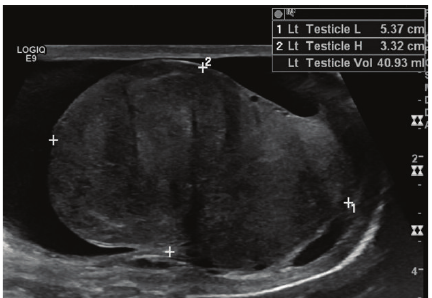
Figure1:Testicularultrasound.Longitudinalexaminationoftheleft testisdemonstratesaheterogeneousmass,whichhasnearlyreplaced all normal testicular parenchyma. A small reactive hydrocele is